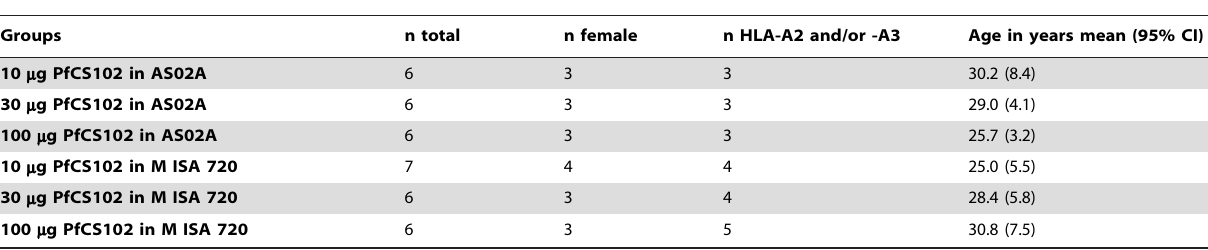
Table 1. Characteristics of participants in various immunization groups.